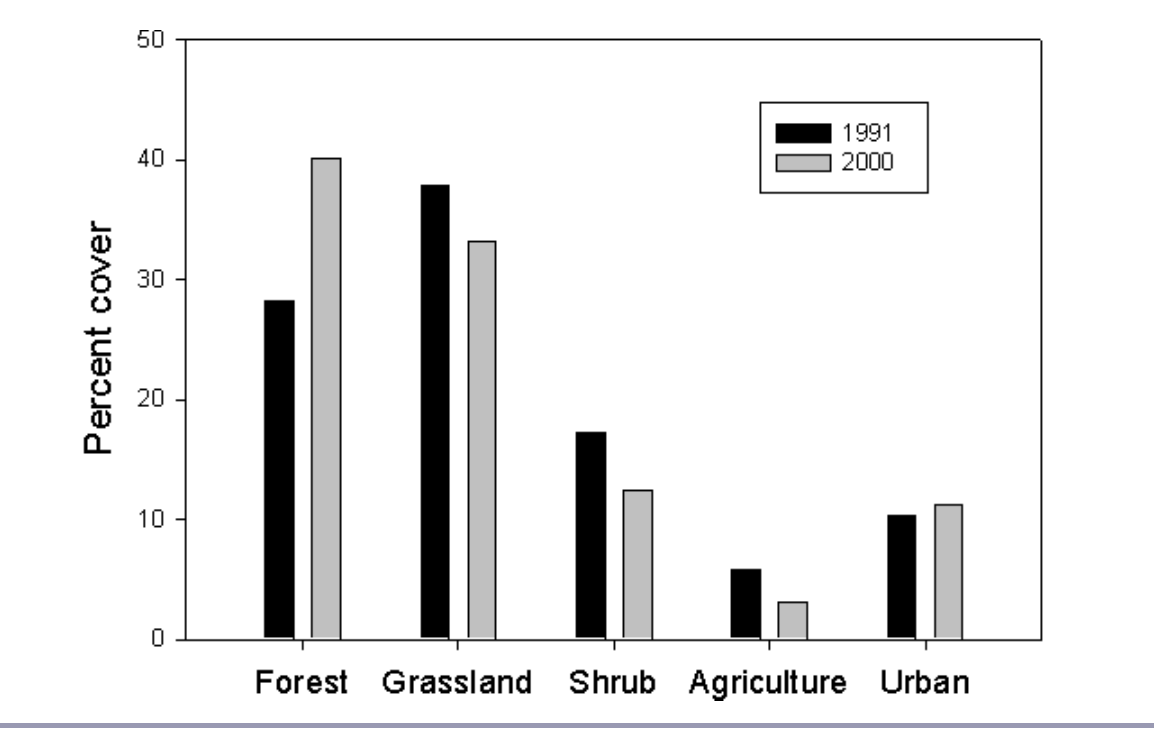
Fig. 3. Percentage land-use change at the island-wide